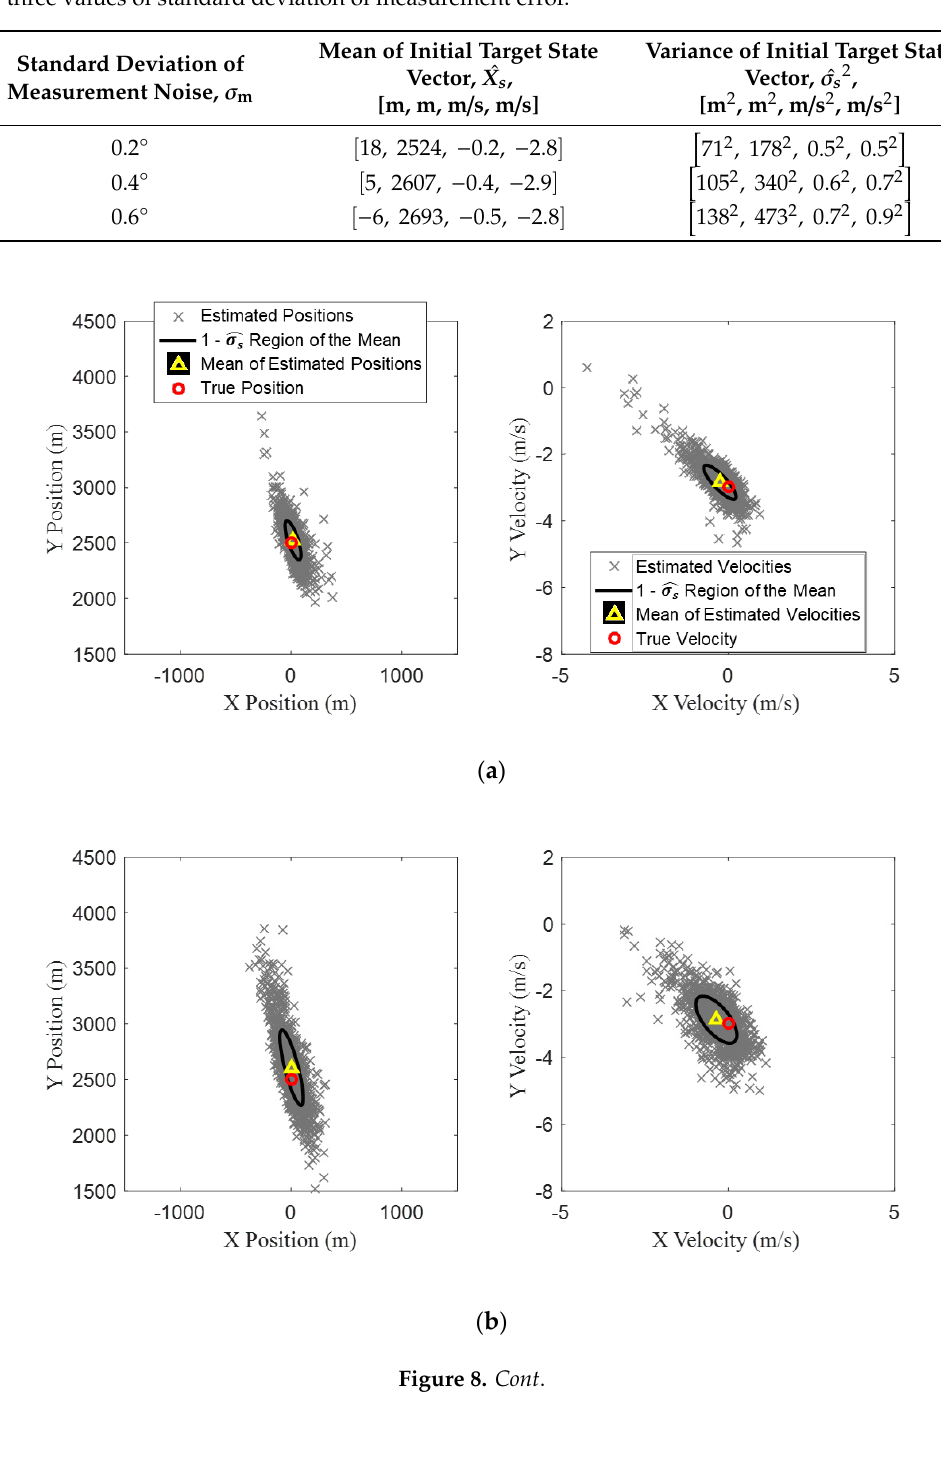
Table 2. The means and variances of the estimated initial state vector [ˆ p xm ( 1 ) , ˆ p ym ( 1 ) , ˆ v xm ( 1 ) , ˆ v ym ( 1 ) ] for three values of standard deviation of measurement error.